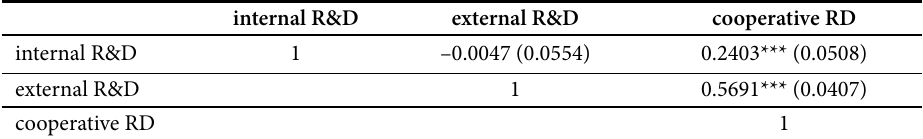
Table 2. Correlation between R&D